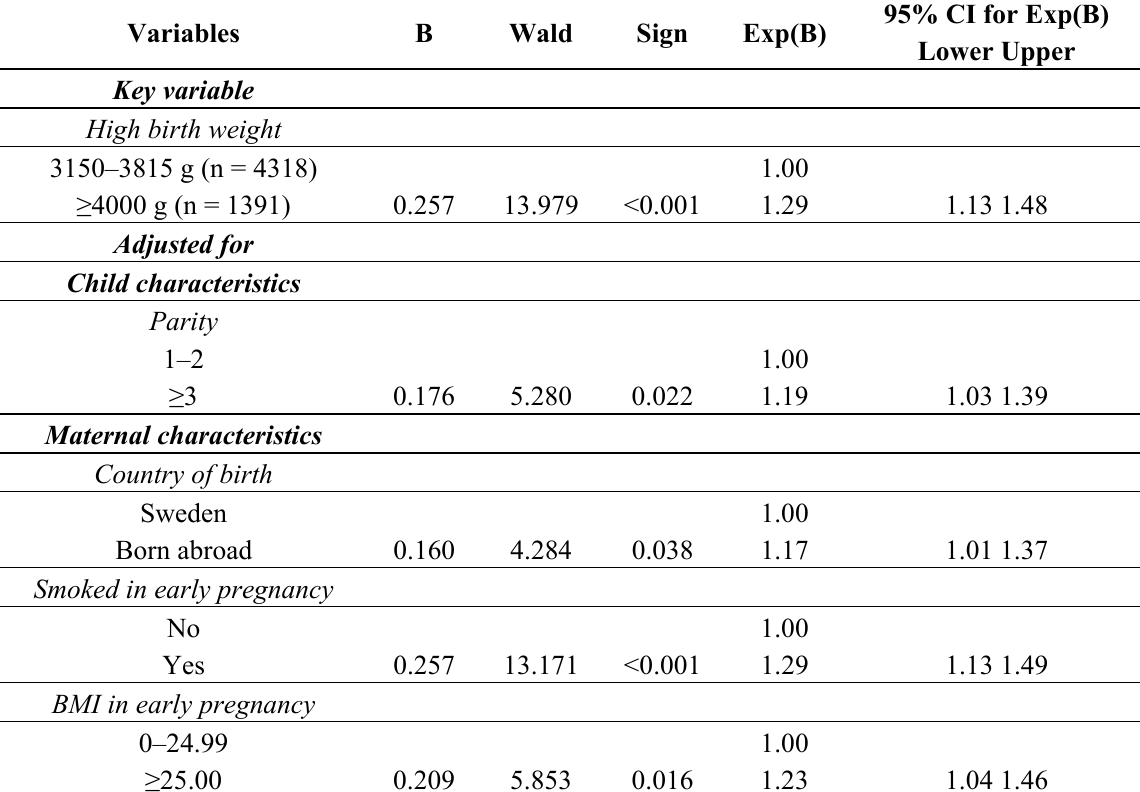
Table 3. Final multivariate logistic regression analysis with total caries increment (DMFT ≥ 1) between 13 and 19 years of age as the outcome and high birth weight ( ≥ 4000 g) as the key